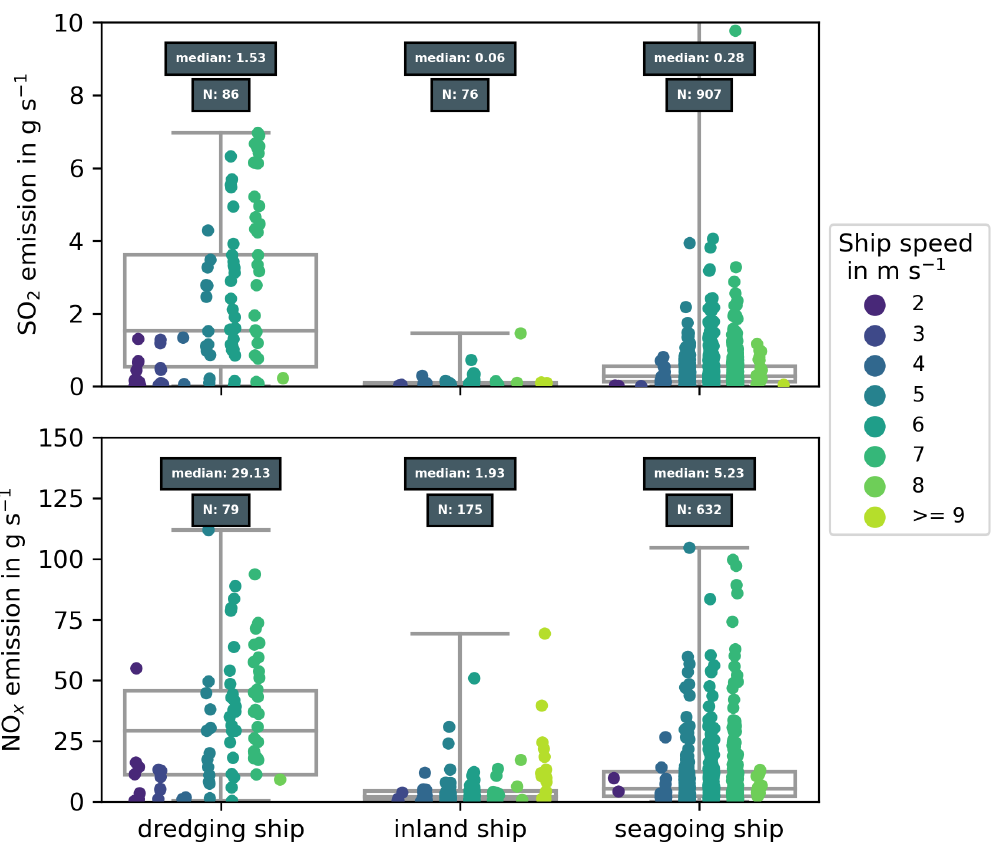
Figure 7. Box plot of SO 2 and NO x emission rates in grams per second for different ship types. Boxes indicate the 25th and 75th percentile, the line in the middle is the median, and the bars show minimum and maximum values. Dots show individual measurements and are colour coded by corresponding ship speed. Dark grey boxes show the median emission rate and total number of observations for each ship type.